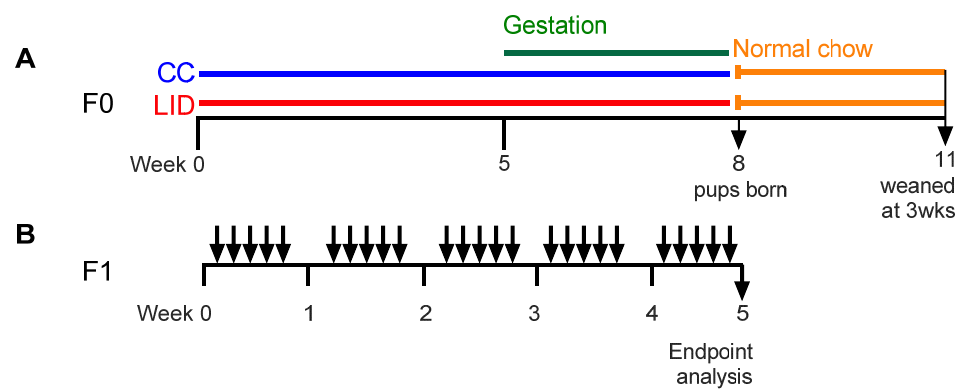
Figure 1. Protocols. ( A ) Six to eight-week-old, female wild type BALB/c mice (F0) received control chow (CC) or low iron diet (LID) from week 0. Timed mating occurred at week five and offspring weaned at three weeks of age. ( B ) Eight-week-old female offspring (F1) treated with house dust mite (HDM; 25 µ g/50 µ L Saline) or saline (Sal; 50 µ L) five days/week for five weeks. Post-partum, all mice were placed onto a normal mouse chow (meat free mouse and rat diet, 200 mg Iron/Kg Specialty Feeds, Glen Forrest, Australia) and offspring (F1) were weaned at three weeks of